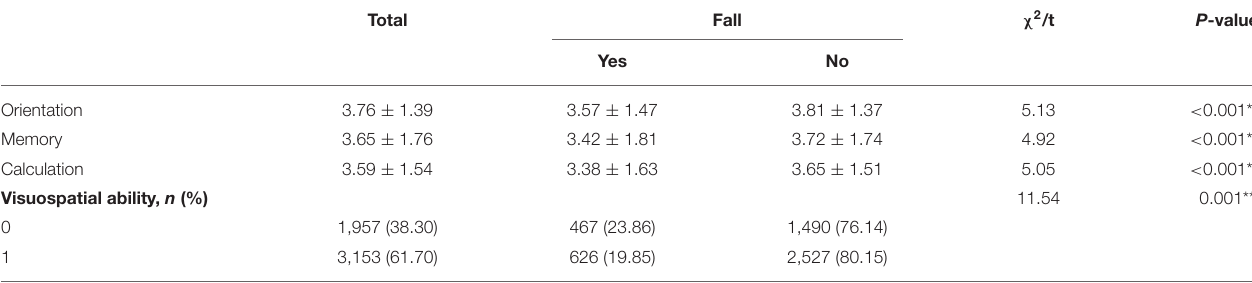
TABLE 3 | Comparison of cognitive domains between the non-fallers group and the fallers group ( n = 5,110).